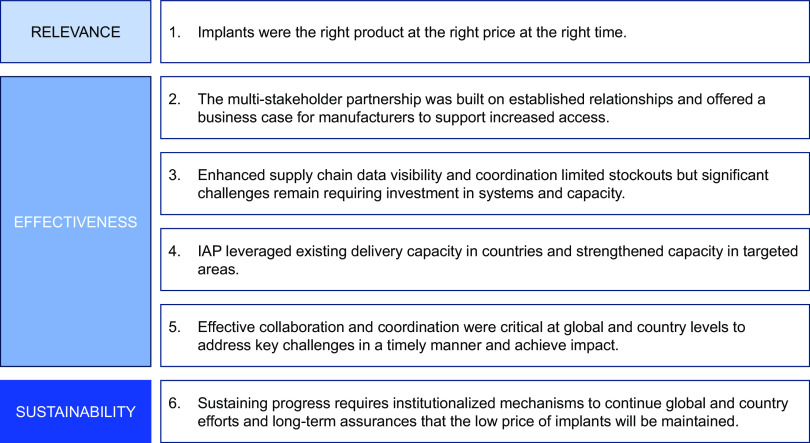
Key Insights from the Implants Access Program Evaluation